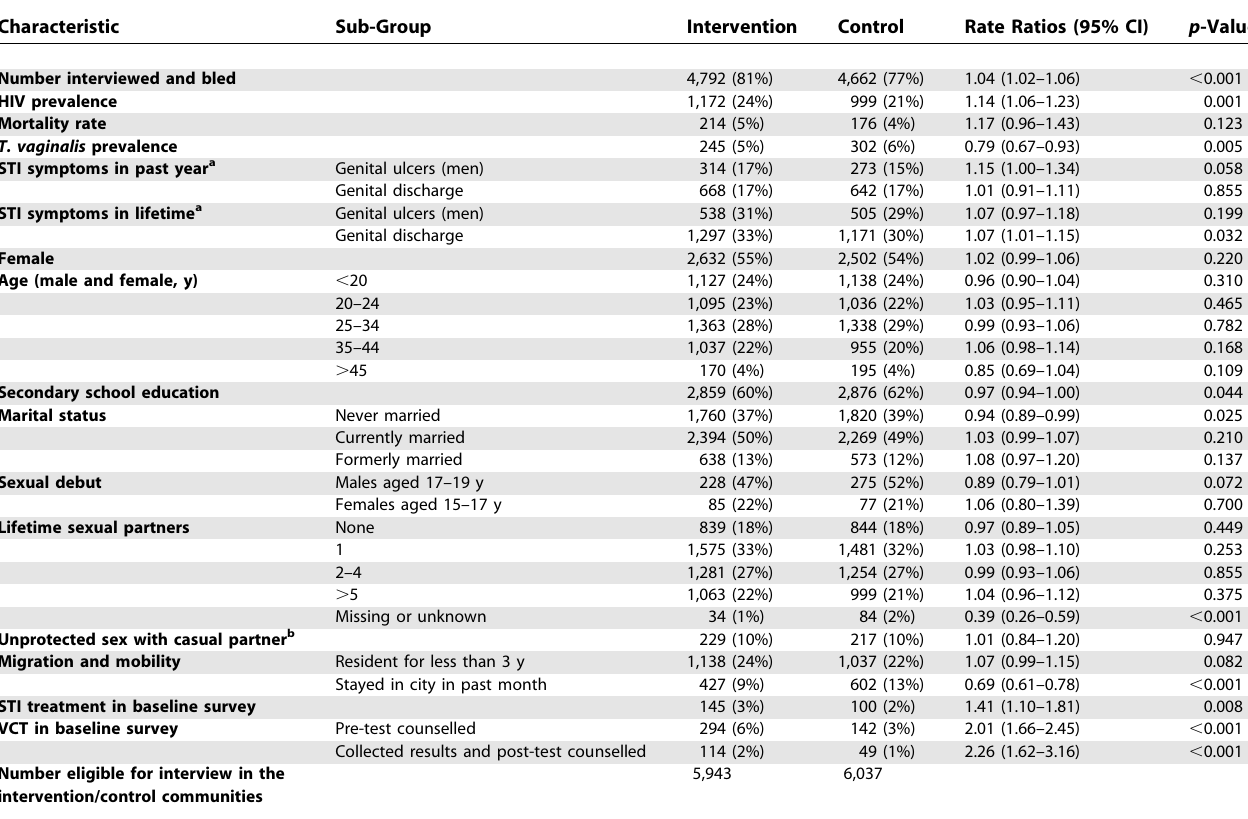
Table 1. Baseline Characteristics of the Study Populations Characteristic